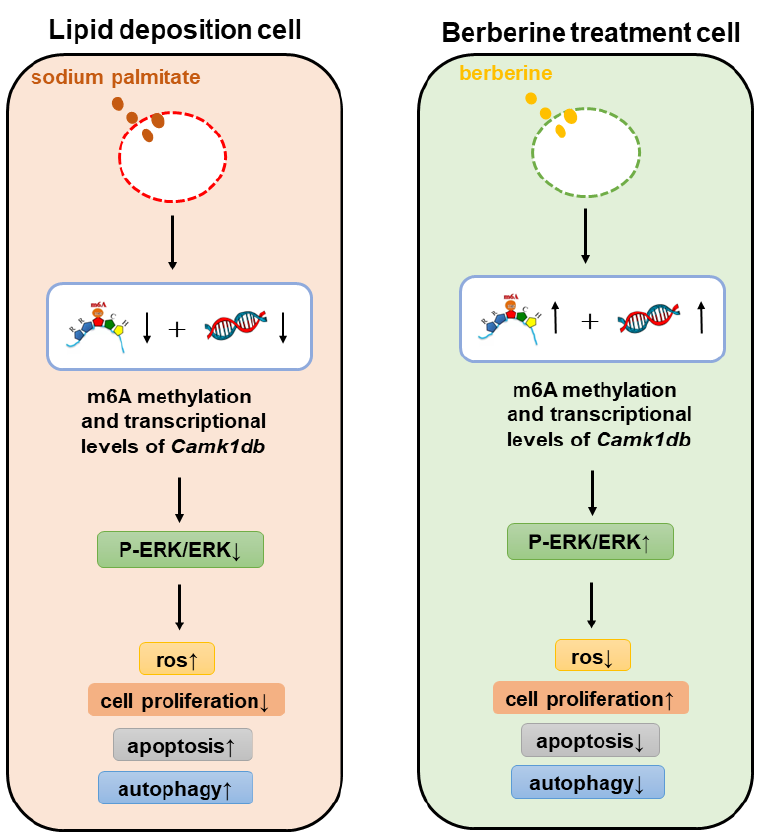
Figure 8. Berberine mediates the mechanism of Camk1db /ERK1/2 signaling pathway.